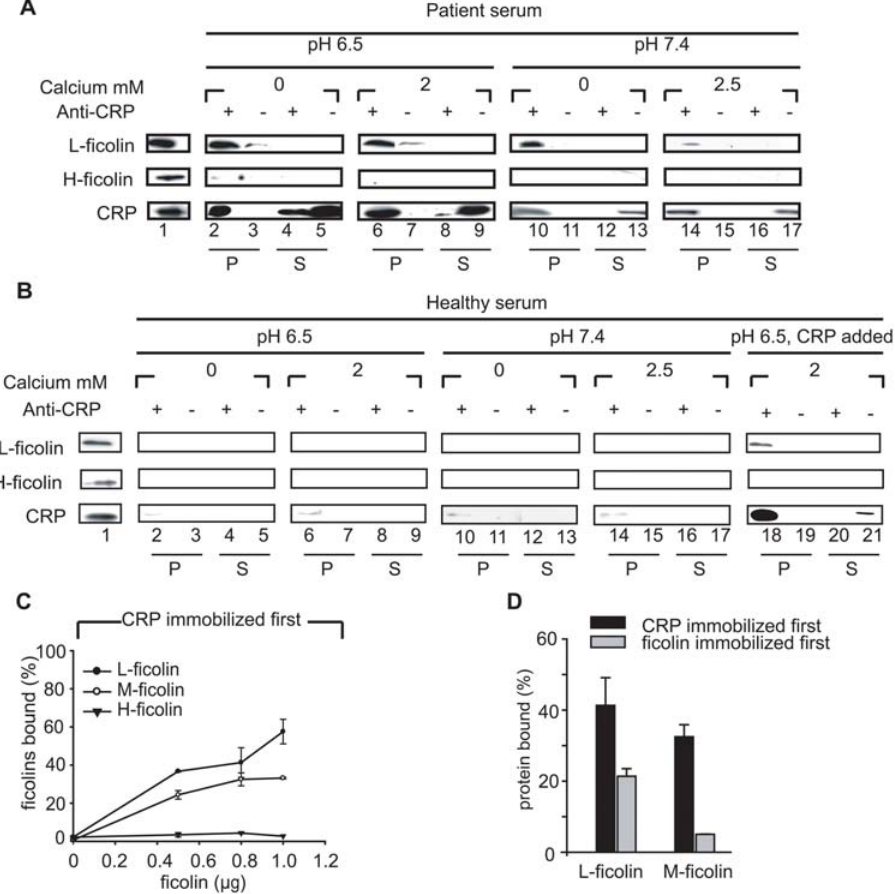
Figure 2. Infection-inflammation triggers CRP and L-ficolin to form complex in serum. The complex of CRP and L-ficolin was co- immunoprecipitated from the patient serum (A) or healthy serum (B) at pH 6.5 and 7.4 with or without calcium. Rabbit polyclonal anti-CRP was added (lanes marked with ‘‘ + ’’) to 500 m l of 10% pre-cleared serum and incubated for 1 h at 4 u C, following which protein A beads were added. As the negative controls (lanes marked with‘‘ 2 ’’), the Co-IP used rabbit polyclonal anti-CrCRP (horseshoe crab, Carcinoscorpius rotundicauda CRP antibody) instead of rabbit polyclonal anti-CRP. The immuno-precipitates (P) on the beads and the proteins in the supernatants (S) were extracted in SDS PAGE loading buffer, and the bound CRP and L-/H-ficolins were identified by mouse monoclonal anti-CRP and anti-L-/H-ficolin antibodies, respectively. In (A) and (B), Lane 1: purified CRP and L-/H-ficolins were loaded for confirmation of the specificity of immunodetection; Lanes 2–5: proteins in precipitates or supernatants under pH 6.5 without calcium; Lanes 6–9: proteins in precipitates or supernatants under pH 6.5 with 2 mM calcium. Lanes 10–13: proteins in precipitates or supernatants under pH 7.4 without calcium; Lanes 14–17: proteins in precipitates or supernatants under pH 7.4 with 2.5 mM calcium. In (B), Lanes 18–21 contained proteins in precipitates or supernatants under pH 7.4, 2.5 mM calcium with addition of 10 m g/ml CRP. (C) ELISA to test the interaction between CRP and L-/H-/M-ficolins when 0.8 m g of CRP was immobilized first. 0, 0.5, 0.8 and 1 m g of L-/ H-/M-ficolins were added to the immobilized CRP, respectively, and the bound proteins were detected by the corresponding antibodies. (D) ELISA to compare the interaction between CRP and L-/M-ficolins in different orders of immobilization with 0.8 m g of either of the ficolins or CRP immobilized first. In (C) and (D), 0.8 m g HSA (instead of CRP or ficolins) was immobilized on the wells to serve as the negative control. The positive control (for 100% binding) constituted 1 m g of the binding proteins [ficolins in (C) and ficolins or CRP in (D)] directly immobilized on the wells and detected by the corresponding antibodies. OD 405 nm was read as the binding signal. Readings were subtracted off negative controls and expressed as a percentage of the corresponding 100% binding control. doi:10.1371/journal.ppat.1000282.g002 (ii) Amplification pathway 2: Infection by Gram negative induced phagocytic efficiencies up to 70% and 54.3%, respective- bacteria containing GlcNAc (a chemical moiety of lipopoly- ly, with , 5% in the other controls (Figure 3C). Taken together, we saccharide) induces the L-ficolin:CRP mediated regulation propose that inflammation drives crosstalk between CRP and L- of the lectin pathway: GlcNAc R L-Ficolin:CRP R C1q R C4 R ficolin from which two new autonomous complement amplifica- C2 R C3 R MAC tion pathways emerge leading to membrane attack complex (MAC) formation and antimicrobial activity: L-ficolin:CRP and CRP:L-ficolin interactions integrate the (i) Amplification pathway 1: Infection by Gram positive classical and lectin complement pathways to enhance bacteria containing PC (a chemical moiety of lipoteichoic antimicrobial activity acid) induces the CRP:L-ficolin mediated regulation of the classical pathway: PC R CRP:L-Ficolin R MASP-2 R C4 R C3 R To determine whether C1q and L-ficolin can bind to CRP MAC simultaneously and which of the two amplification pathways is